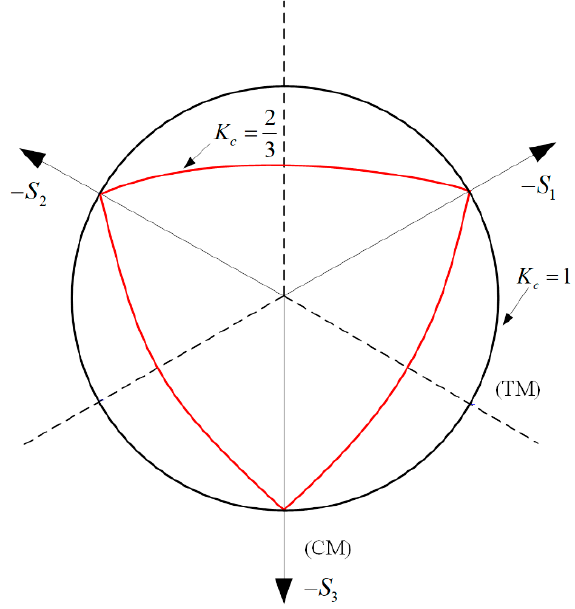
Figure 5. Yield surface in the deviatoric plane, corresponding to different values of K c .